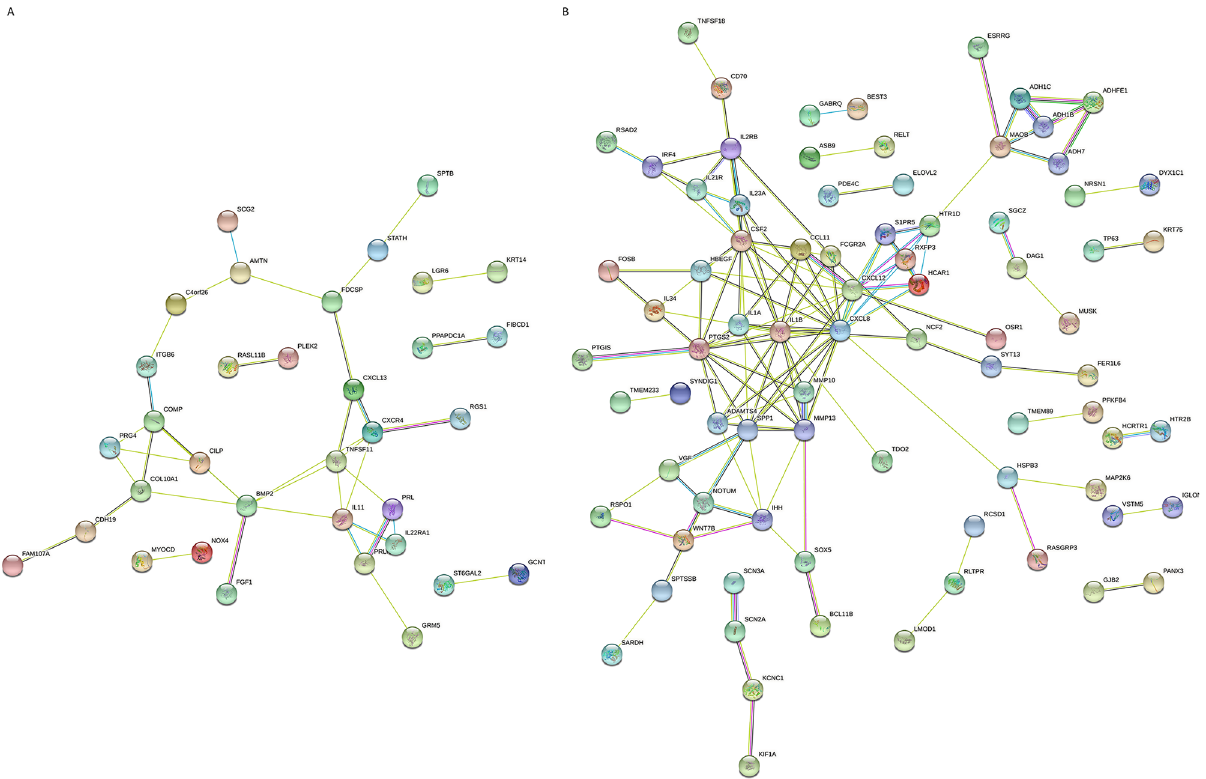
Figure 3. ADL induced gene expression in fibroblasts by RNAseq. STRING analysis of genes regulated by ADL which are ( A ) dependent and ( B ) independent of the TGF ‐ β RI kinase inhibitor. The number of unconnected bubbles, excluded from the figure is 43 and 72 in ( A ) and ( B ), respectively. ( A ) We noticed the presence of IL11, NOX4 and PRG4, which were already identified in previous studies to be regulated in a SB431542-dependent way. ( B ) Obvious are the expression of the inflammatory cytokines and chemokines, along with some of the proteases indicating an SB431542-independent proinflammatory cell response. Network of interactions were depicted using String database (https:// string- db. org).